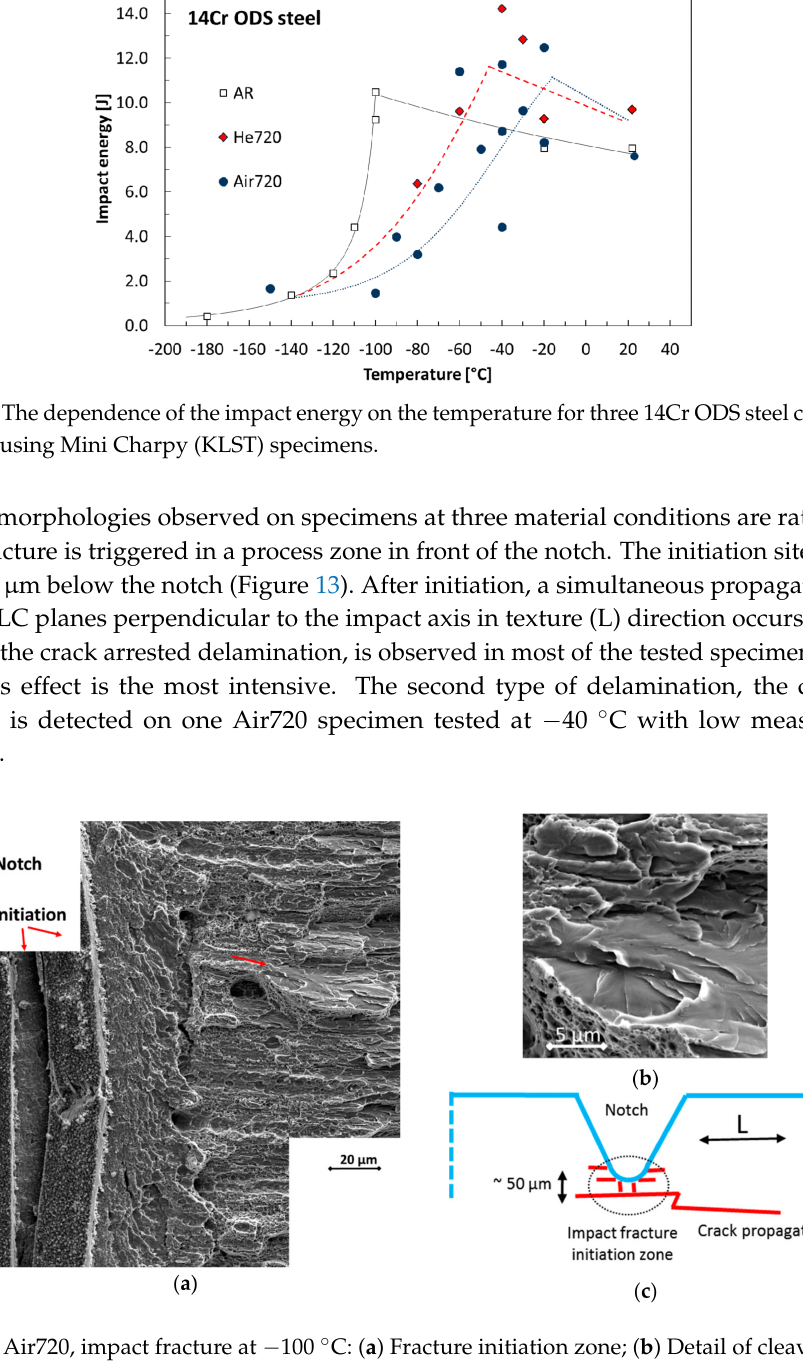
Figure 13. Air720, impact fracture at − 100 ◦ C: ( a ) Fracture initiation zone; ( b ) Detail of cleavage facet from ( a ); ( c ) Schematic of preferential orientation of initiated cracks in the impact fracture